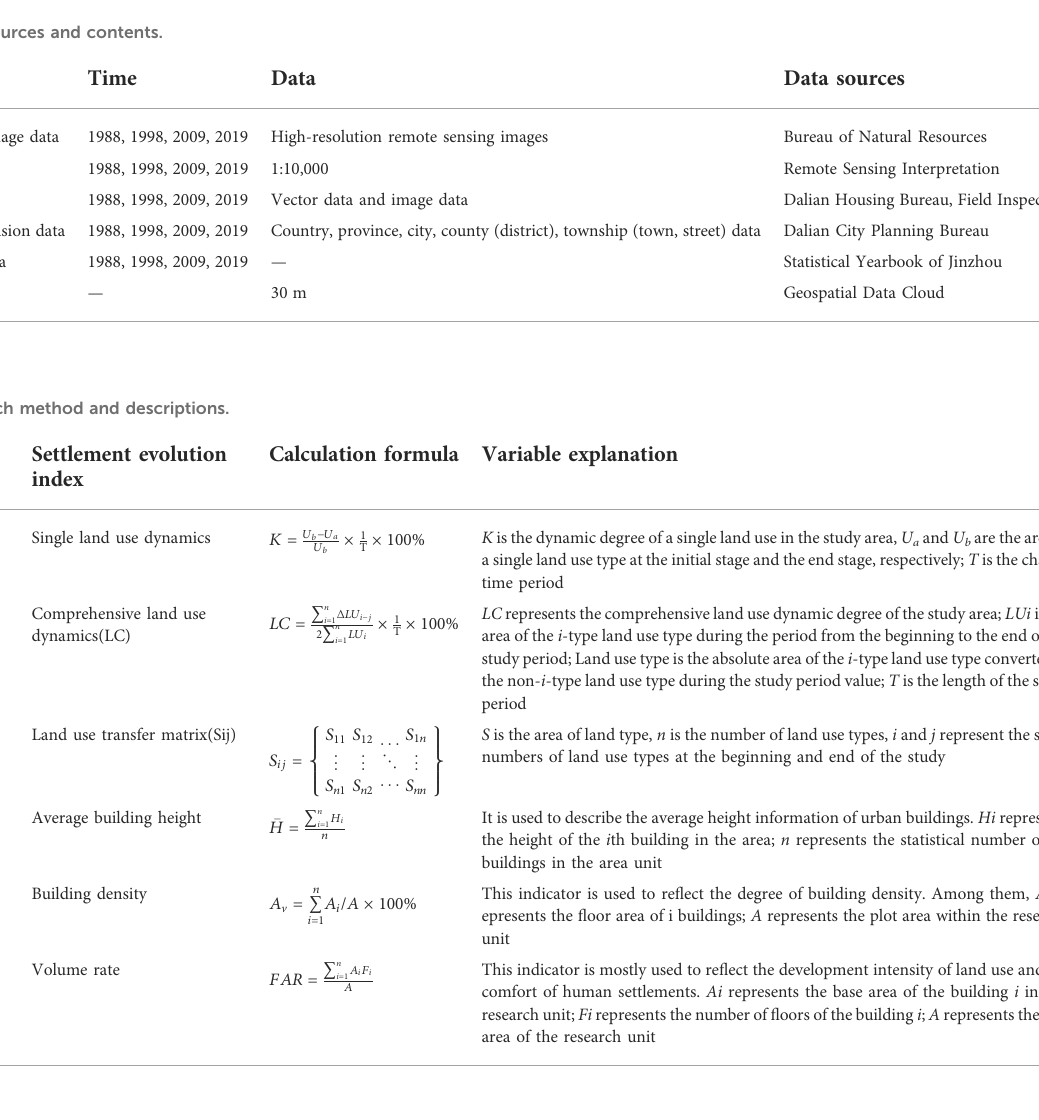
TABLE 1 Data sources and contents.